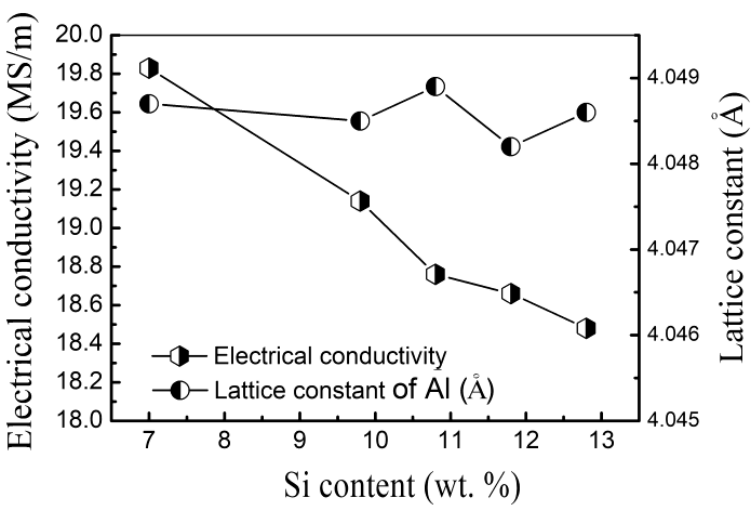
Figure 2. Relationship between Si content and electrical conductivity, and lattice constant.